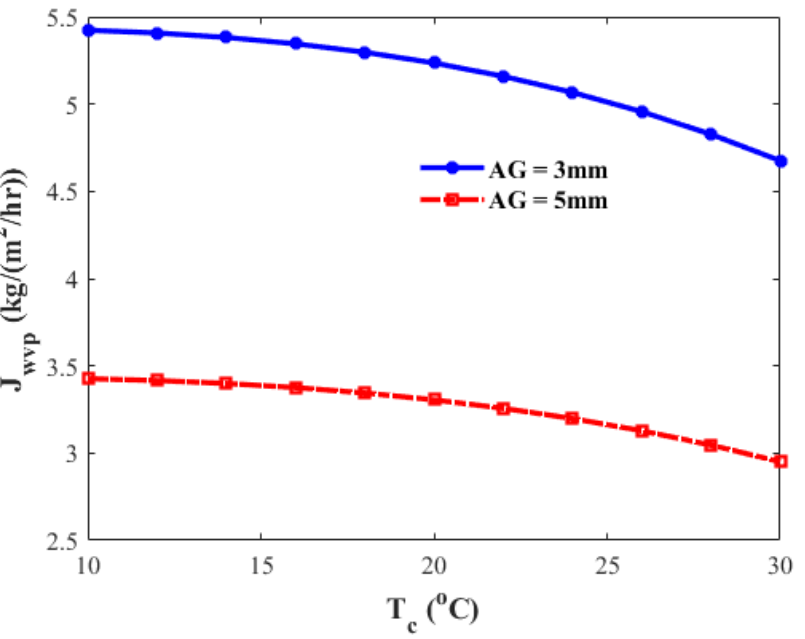
Figure 15. Effect of the air gap thickness (AG = 3 and 5 mm) on the J wvp at different cold feed temperatures (T c ) (hot feed of 2 L/min and cold feed of 1 L/min).